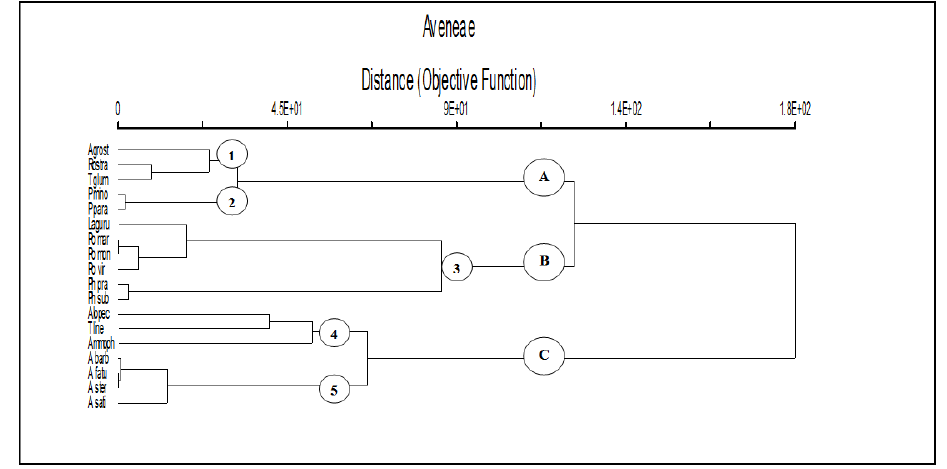
Fig. 1. Dendrogram of Aveneae based on analysis of characters recorded in Tab. 4 under a combina- tion of Euclidean distance measure and Ward’s clustering method. % chaining =